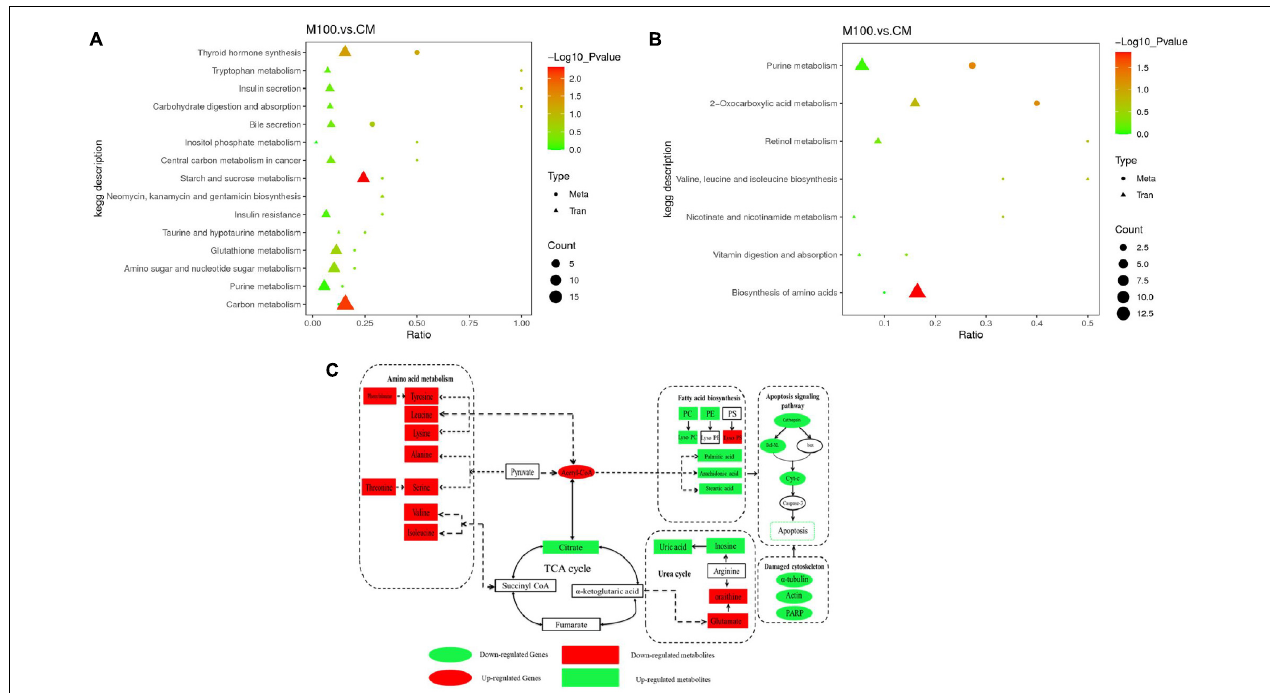
FIGURE 5 | (A) Kyoto Encyclopedia of Genes and Genomes pathways analysis of association analysis between transcriptome and metabolome in the positive ion mode. (B) Kyoto Encyclopedia of Genes and Genomes pathways analysis of association analysis between transcriptome and metabolome in the negative ion mode. (C) Correlation map of genes and metabolites regulated by Axn feeding in the muscle of Exopalaemon carinicauda . The altered genes and metabolites are shown by marking the names in red (upregulated) or green (downregulated).